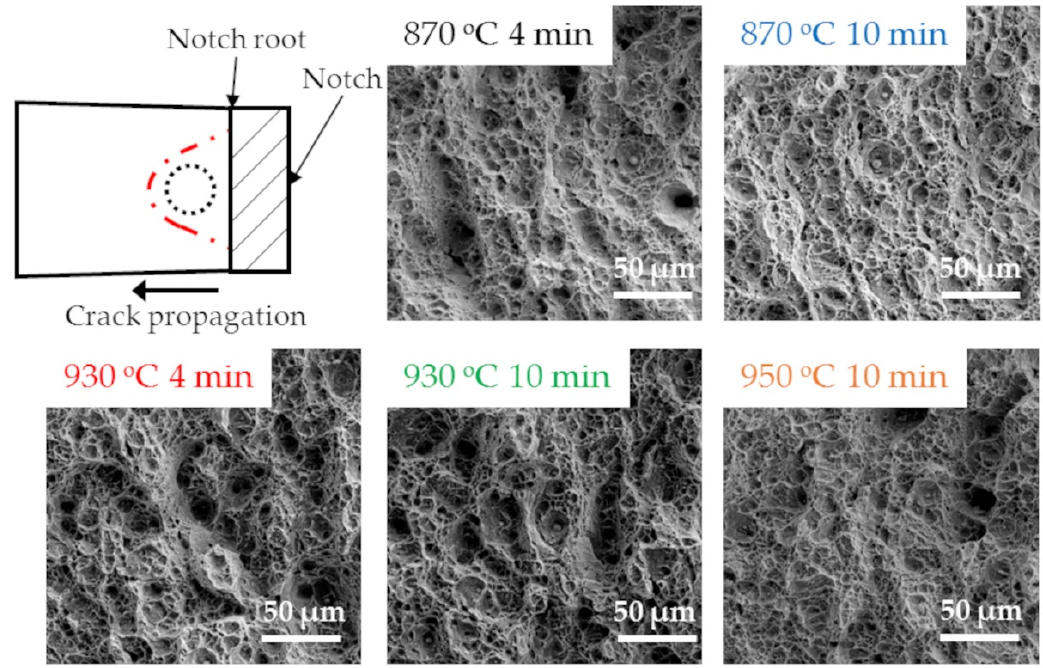
Figure 11. SE-SEM images taken from a location that lies within the thumbnail-shaped region on the fracture surface near the initial notch root of the single-edge notch specimens (as shown in the schematic) of the five heat-treated martensitic steel. The loading direction is into the viewed plane.